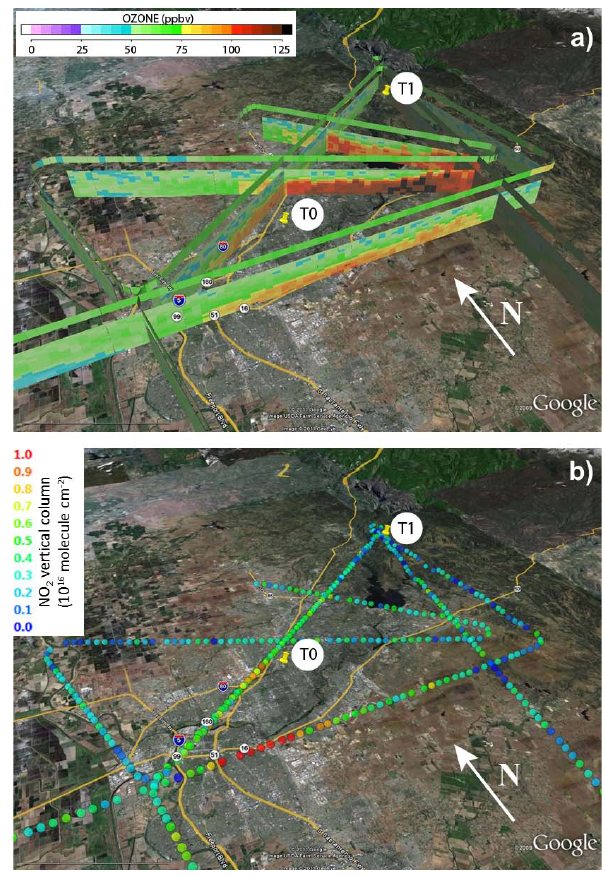
Fig. 25. (a) Ozone mixing ratio profiles measured with the TOPAZ lidar and (b) NO 2 vertical column densities measured with the CU AMAX DOAS system over the Sacramento area on 28 June. Data are from two flight segments from 11:28–12:03 and 13:04– 13:52 PDT. The ozone profiles extend from near the ground to 1500mm.s.l. The colored line above the ozone “curtain” plot rep- resents the ozone in situ measurements at flight level (approx. 2100mm.s.l.). The locations of the T0 and T1 ground sites are in- dicated by yellow pushpin